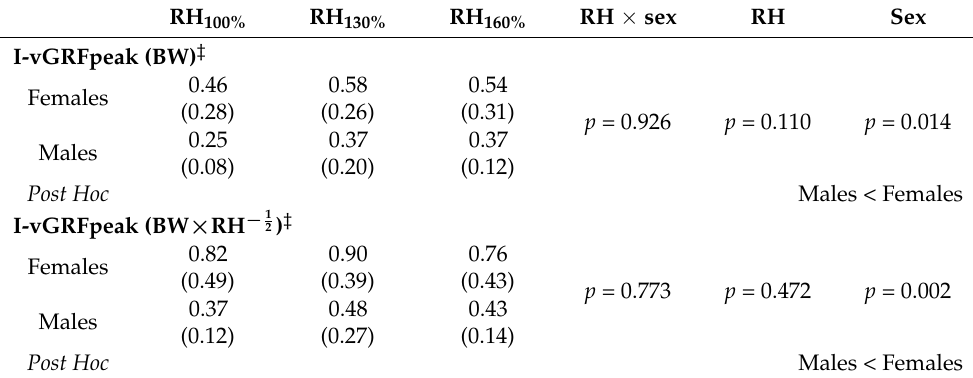
Figure 2. The side-to-side differentials in starting contacts between the dominant and nondominant limbs. JH = jump height of the countermovement jump. ‡ Significant sex main effect ( p < 0.05). The absolute differences in I-vGRFpeak between the dominant and nondominant limbs are shown in Table 3. No interaction between height and sex was observed when normalized by BW ( p = 0.926) or by BW × RH − 1 2 ( p = 0.773). No significant main effect of height was observed (BW: p = 0.110; BW × RH − 1 2 : p = 0.472). The absolute differentials of females were significantly greater compared to those of males (BW: p = 0.014; BW × RH − 1 2 : p = 0.002). Table 3. Side-to-side differences of the